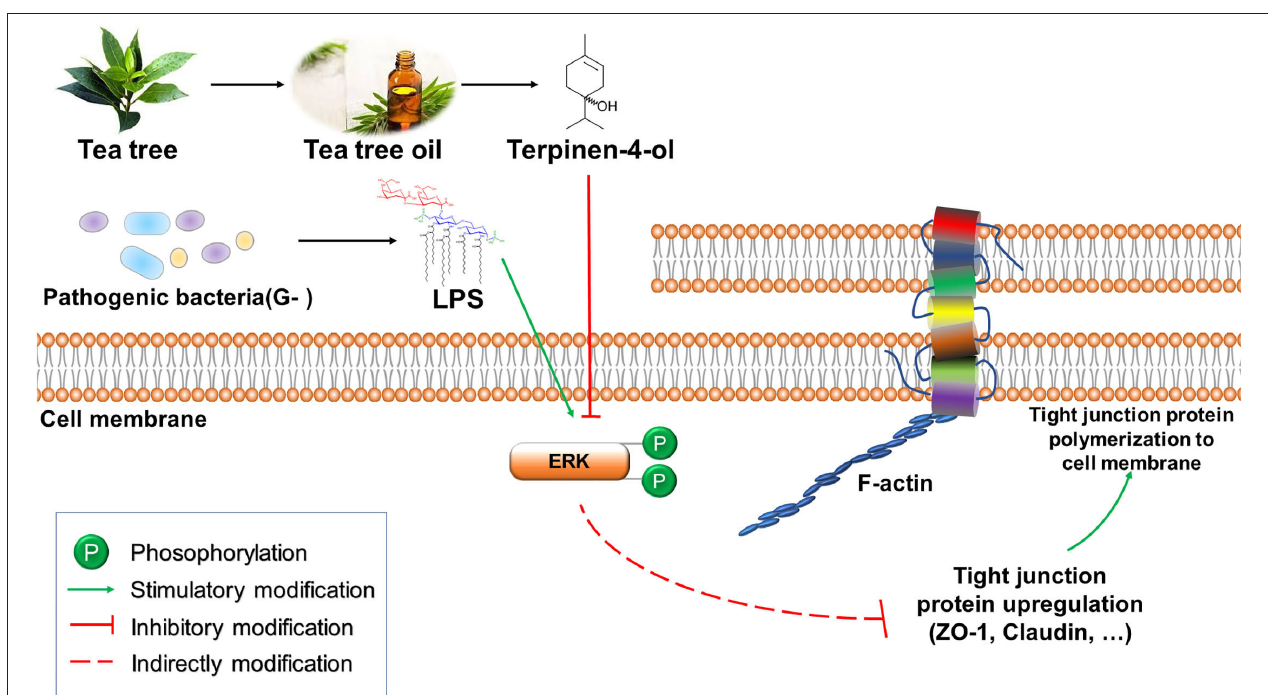
FIGURE 10 | The putative signal pathway of terpinen-4-ol (TER) protects gut integrity in IPEC-J2 cells. TER attenuated LPS induces downregulation of tight junction proteins via the ERK1/2 signal